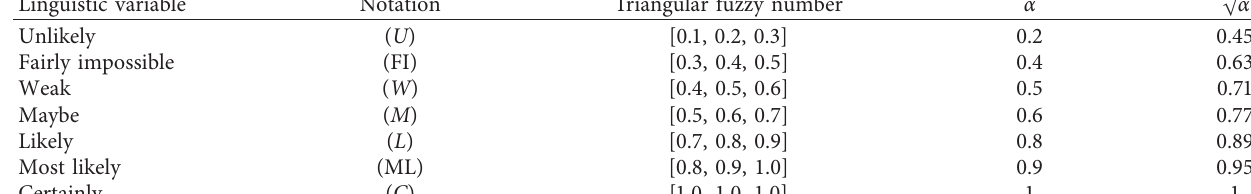
Table 3: The linguistic variables used and their corresponding fuzzy numbers of Z-number in probabilistic conditions. Linguistic